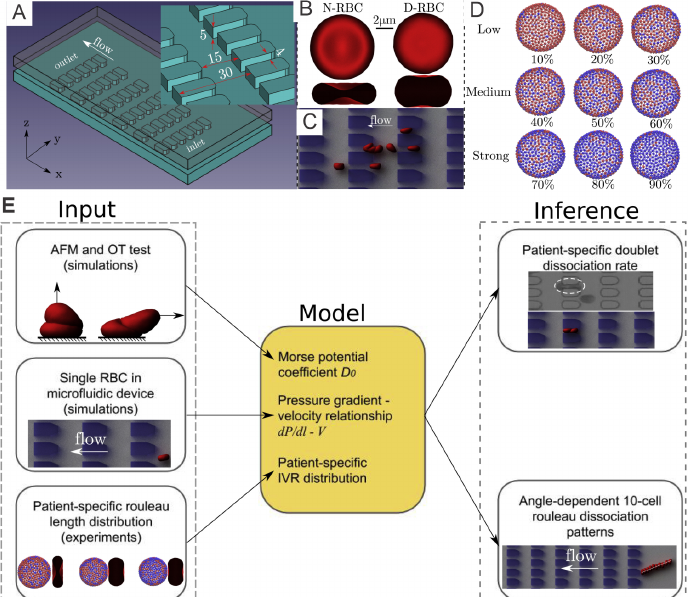
Figure 2. ( A ) A microfluidic device with periodic obstruction is designed for examination of the biomechanics of diabetic RBCs. ( B ) Schematic of a normal RBC (N-RBC) model, which stays as a biconcave shape with surface-to-volume ratio ( A / V ) of 1.44 whereas a T2DM RBC (D-RBC) model has a more oblate shape with A / V = 1.04. ( C ) An example of simulation results of a T2DM rouleaux travelling through microchannels. ( D ) Fibrinogen-dependent RBC aggregation model where blue vertices denoting “interactive vertices” (IVs) that is able to bind with vertices of the same type located on other RBCs. ( E ) Work pipeline employed to combine in-vivo and in-silico studies. Figures are adopted from [71] with